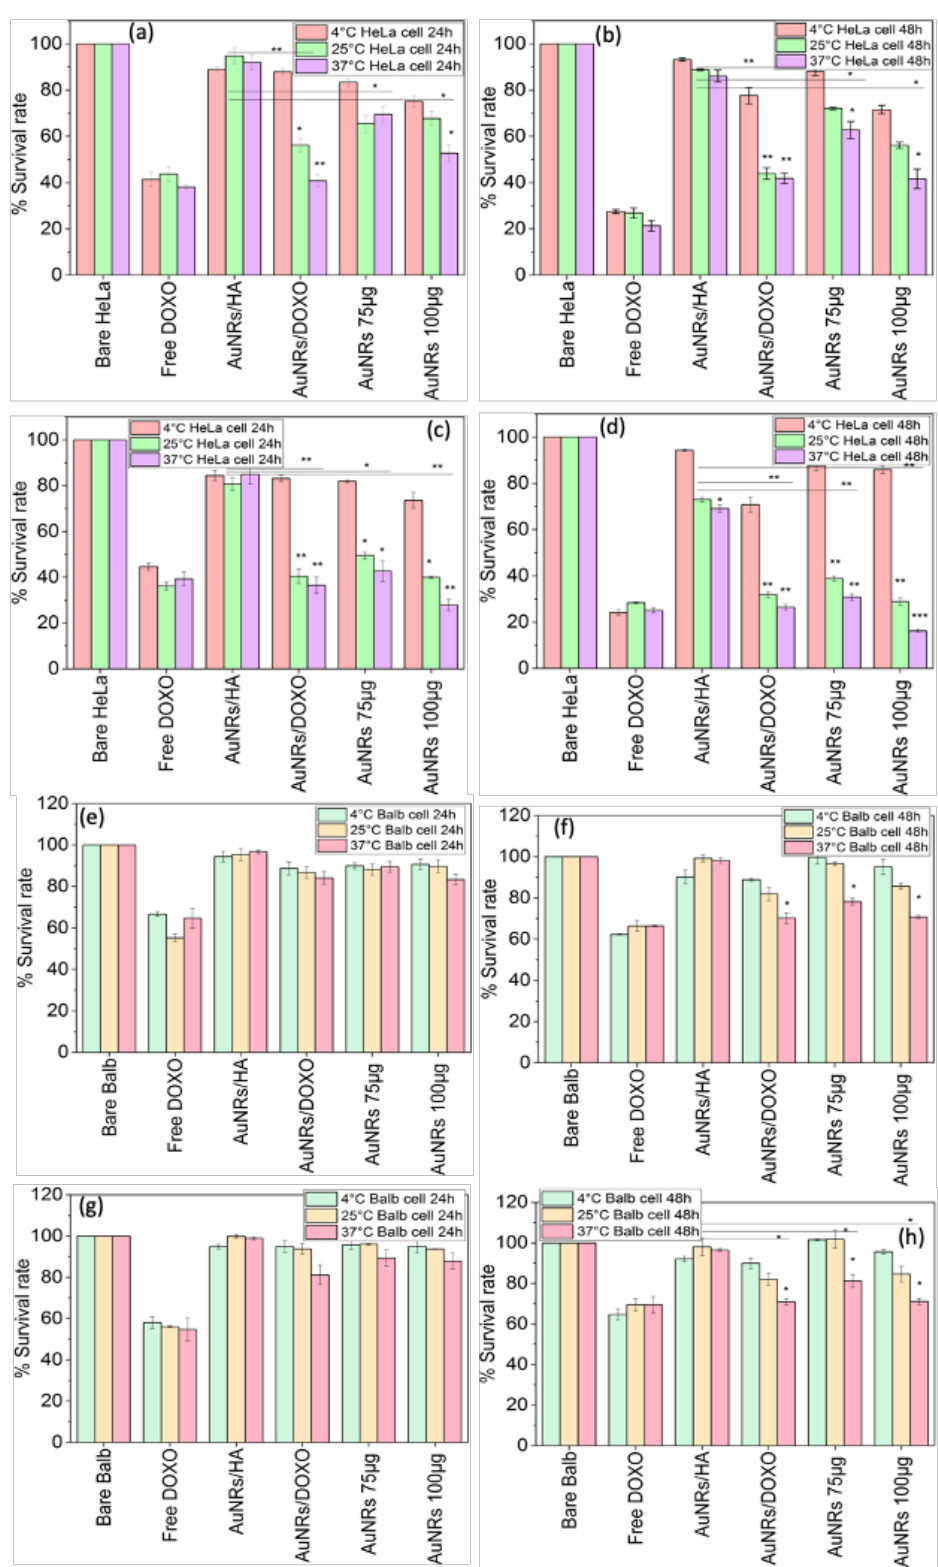
Figure 4. Cellular cytotoxicity expressed as survival rate of ( a – d ) HeLa and ( e – h ) 3T3 Balb cells at different incubation times and temperatures in the presence of NIR light illumination of ( a , b , e , f ) 1.0 and ( b , d , f , h ) 2.0 W/cm 2 . AuNRs/HA denote PSS/PLL/HA-coated NPs, AuNRs/DOXO correspond to PSS/DOXO-coated AuNRs, and AuNRs 75 µg and AuNRs 100 μ g stand for PSS-/DOXO-PLL/HA-